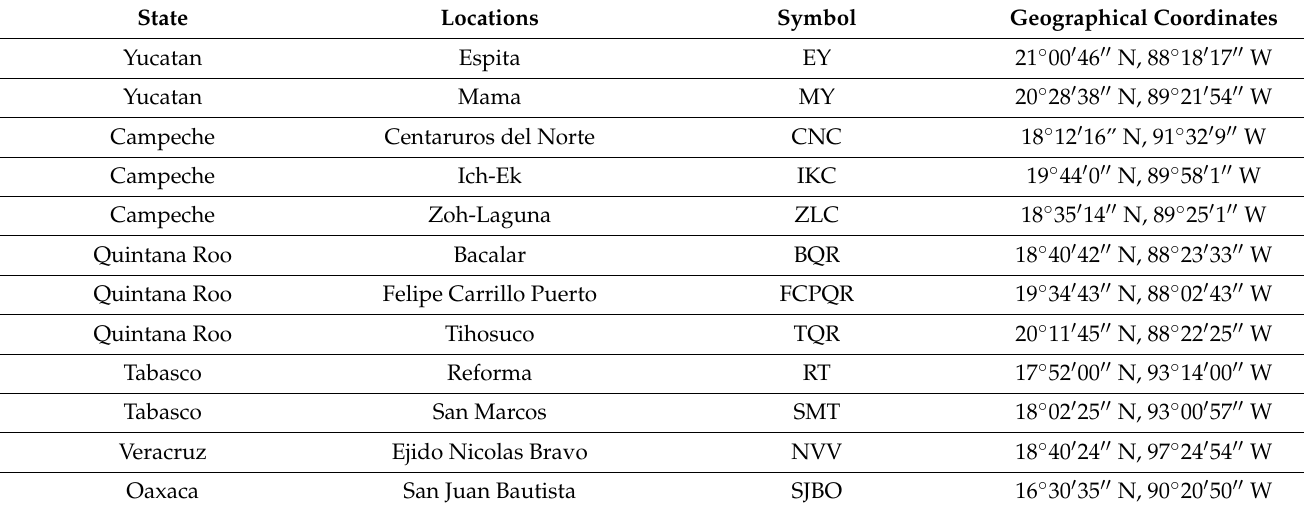
Table 1. The propolis samples, collected states, locations, symbols, and geographical